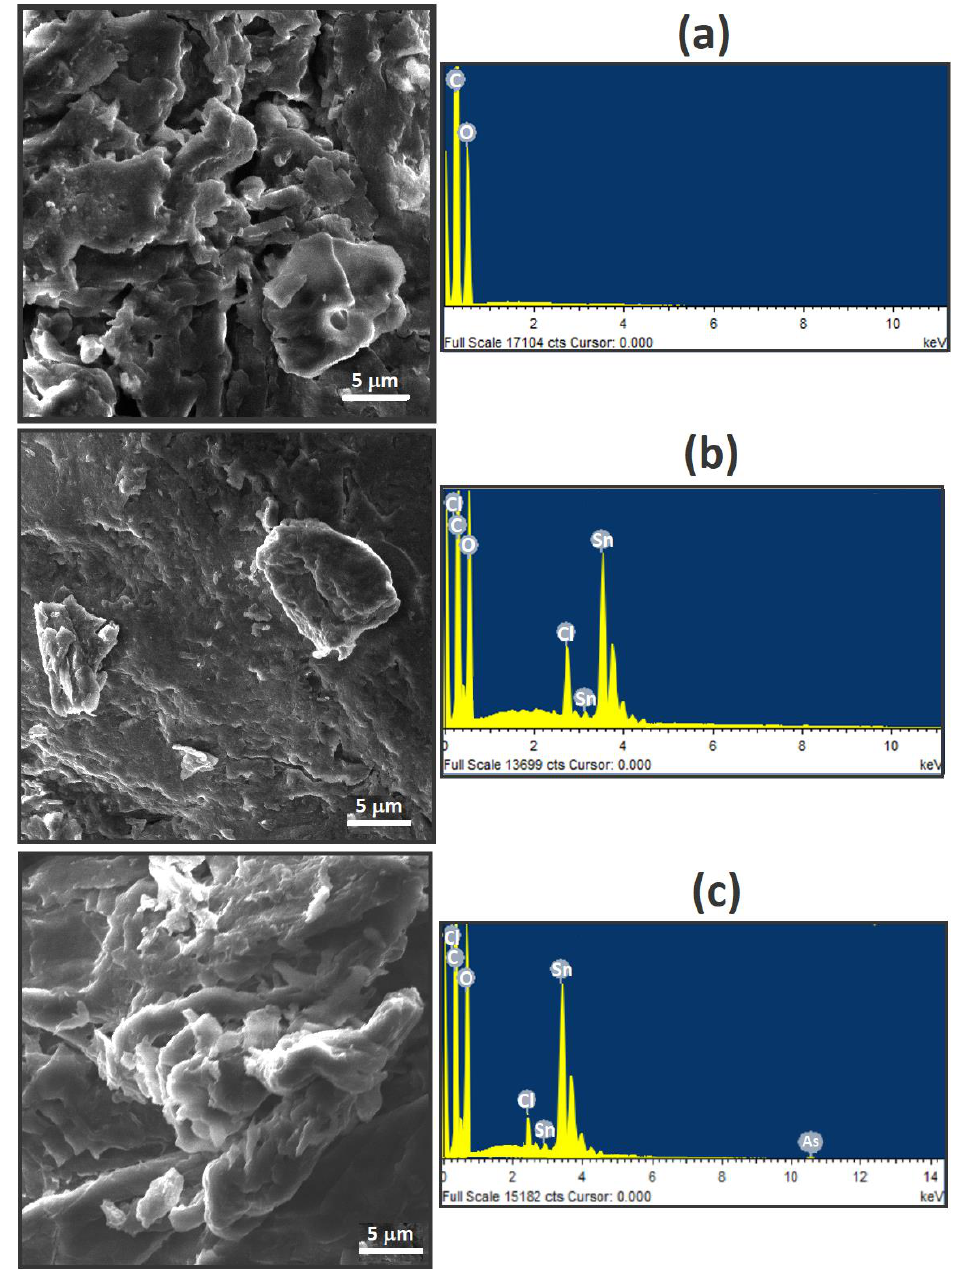
Figure 4. SEM micrograph EDX spectra of ( a ) cellulose, ( b ) CSn, and ( c ) CSn after adsorption of As(III).